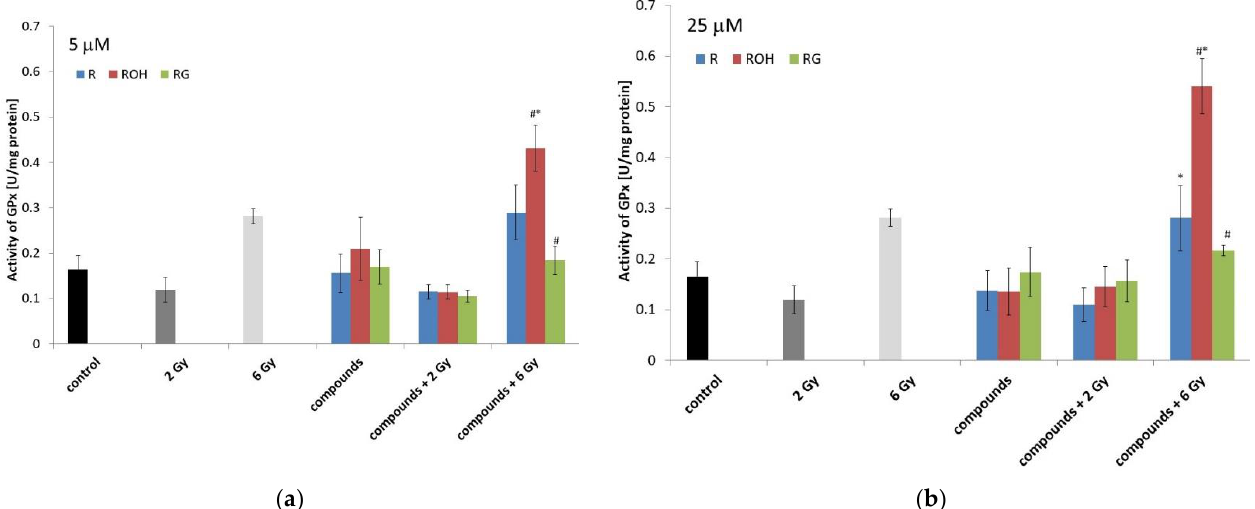
Figure 9. Effect of resveratrol (R), piceatannol (ROH), piceid (RG), ionising radiation, and their combinations on the glutathione peroxidase (GPx) activity of MCF-7 cells. GPx activity was measured after incubation of the cells for 48 h. Cells were treated with stilbene derivatives at concentrations of 5 μM ( a ) and 25 μM ( b ). The presented data are the average of three independent experiments, shown as the mean ± SD (two-way analysis of variance (ANOVA) followed by Tukey’s post hoc test, p < 0.05). The mean difference (*) was compared with the control and (#) with IR.